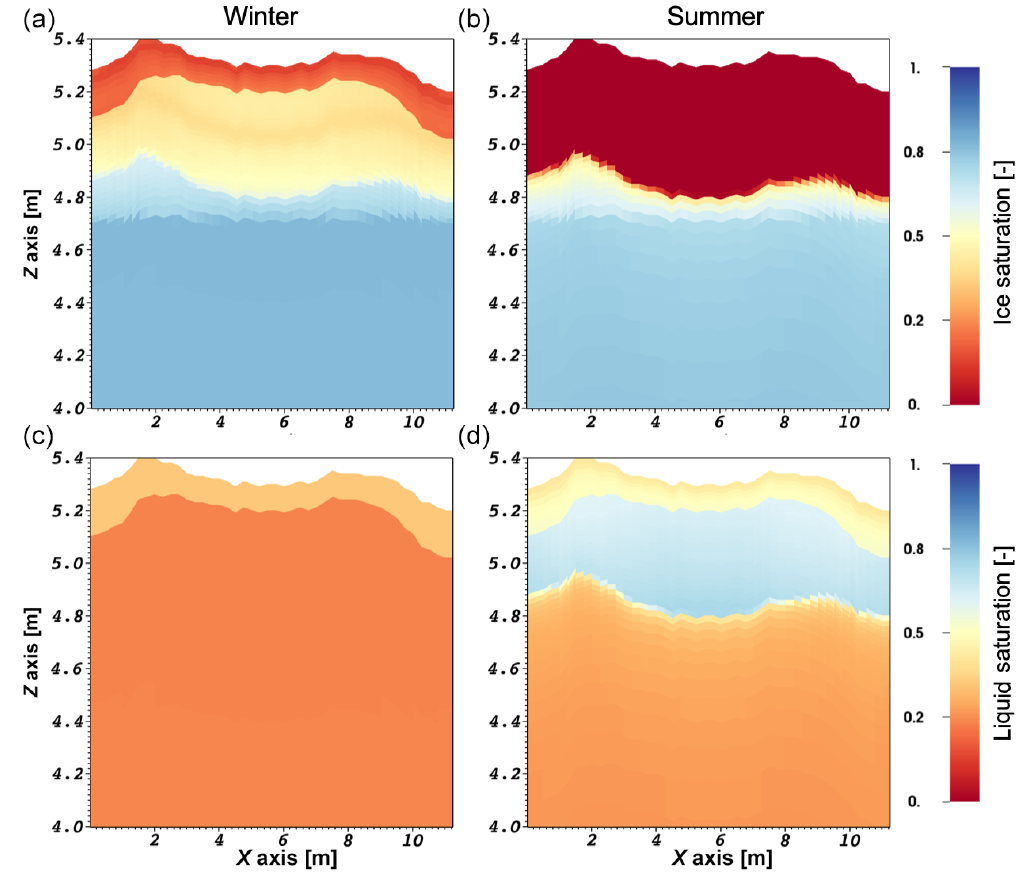
Figure 3. The 2-D transects of daily snapshots simulated by the ATS model. The rows from top to bottom correspond to ice saturation (a, b) and liquid saturation (c, d) . The columns from left to right correspond to a day in the middle of the winter and the day of maximum active layer depth in